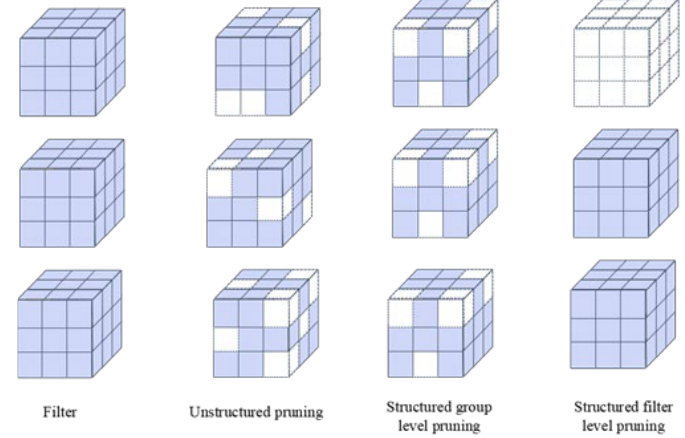
Figure 1. Schematic representation of model pruning.